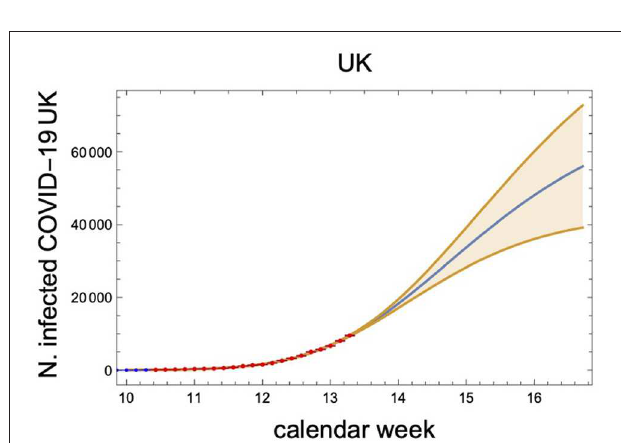
FIGURE 14 | COVID-19 infected cases in the United Kingdom as function of the calendar week number. The curve and the band (90% confidence level) have been obtained by performing a fit w.r.t. a , b , and γ to the red data points.